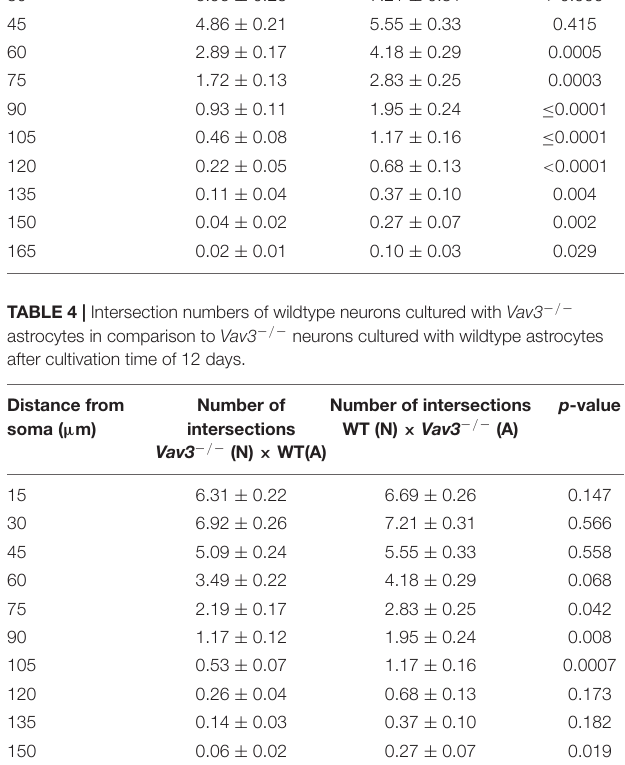
FIGURE 2 | (G) The quantification of the dendritic lengths revealed a significant increase in Vav3 − / − neurons cultured with wildtype astrocytes and in native neurons cultured with Vav3 − / − astrocytes in comparison to the controls. Dots are representing single analyzed dendrites. (H) In contrast, the number of dendrites was slightly reduced in the cultures consisting of wildtype neurons combined with Vav3 − / − astrocytes. Dots are representing individual neurons analyzed regarding their number of dendrites. Statistics: For the Sholl analysis five experimental repetitions ( N = 5) were performed for the culture combinations WT(N)/WT(A) and Vav3 − / − (N)/WT(A) while three experimental repetitions ( N = 3) were performed for the combination WT(N)/ Vav3 − / − (A). Furthermore, 40 neurons ( n = 40) were recorded and analyzed per experimental repetition. For the dendritic lengths and numbers 3 experimental repetitions ( N = 3) were performed with 20 quantified neurons ( n = 20) per repetition. Kruskal-Wallis test with a following Dunn’s multiple comparison test; * p ≤ 0.05, ** p ≤ 0.01 and *** p ≤ 0.001, data are represented as mean ± SEM. Scale bar: 50 µ m.